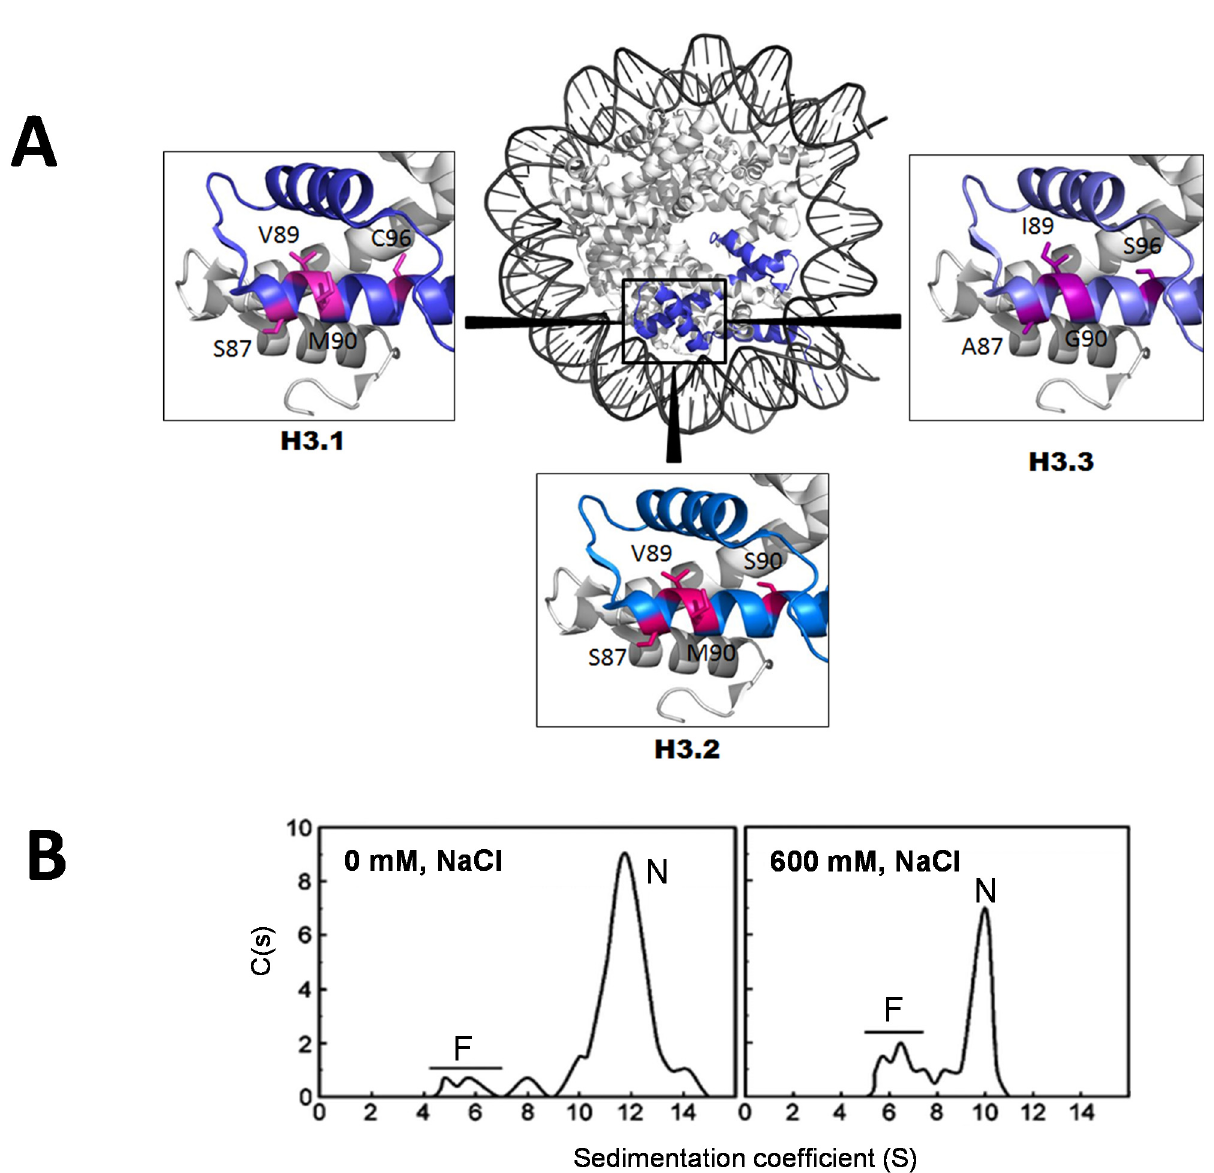
Figure 5. ( A ) Figures were obtained from the crystallographic structures of the H3.1 [134], H3.2, and H3.3-containing nucleosomes [128]. The amino acid residues where the sequences differ in the α 2 helix of the histone fold are shown in fuchsia. The generic image of the nucleosome is from the early crystallographic analysis by Luger et al. (1997) [78]; ( B ) Ionic strength (NaCl)-dependent stability of reconstituted nucleosome core particles containing H2A.Z and H3.3 histones, as visualized in the analytical ultracentrifuge [68]. D: free DNA, N: nucleosomes, s 20,w : sedimentation coefficient corrected for standard water and 20 °C conditions. The DNA used in the nucleosome reconstitutions was 155 ± 5 bp random sequence DNA fragments purified from chicken erythrocyte nucleosome core particles